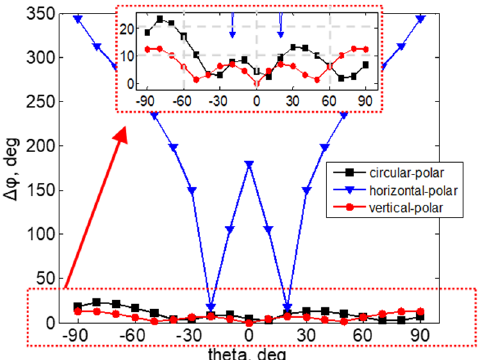
Figure 12. Absolute phase-difference deviation against DOA (θ) under three polarization scenarios of incoming signals.